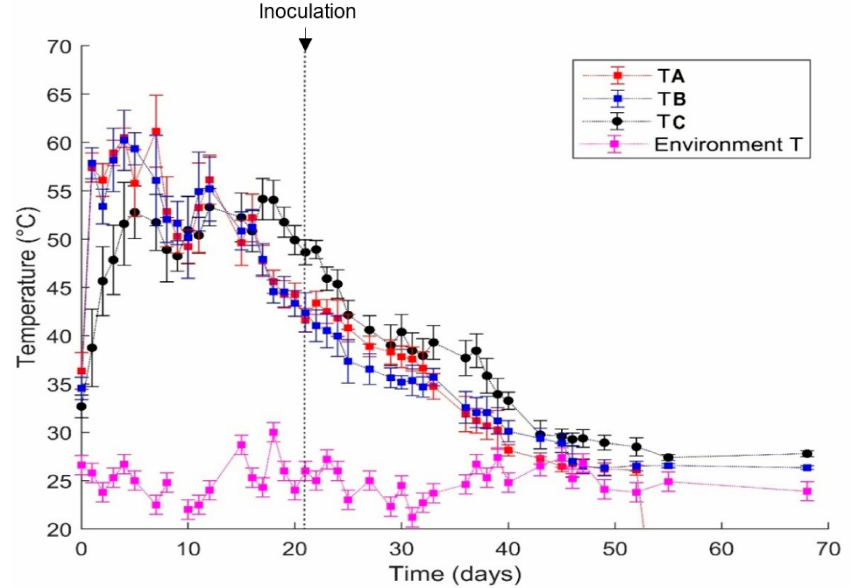
Figure 1. Temperature profiles during the composting